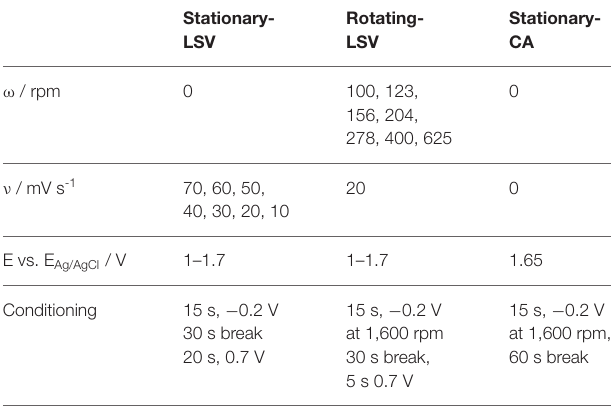
TABLE 1 | Overview of all linear sweep (LSV) and chronoamperometry (CA) measurements with corresponding pretreatments. Stationary- Rotating- LSV